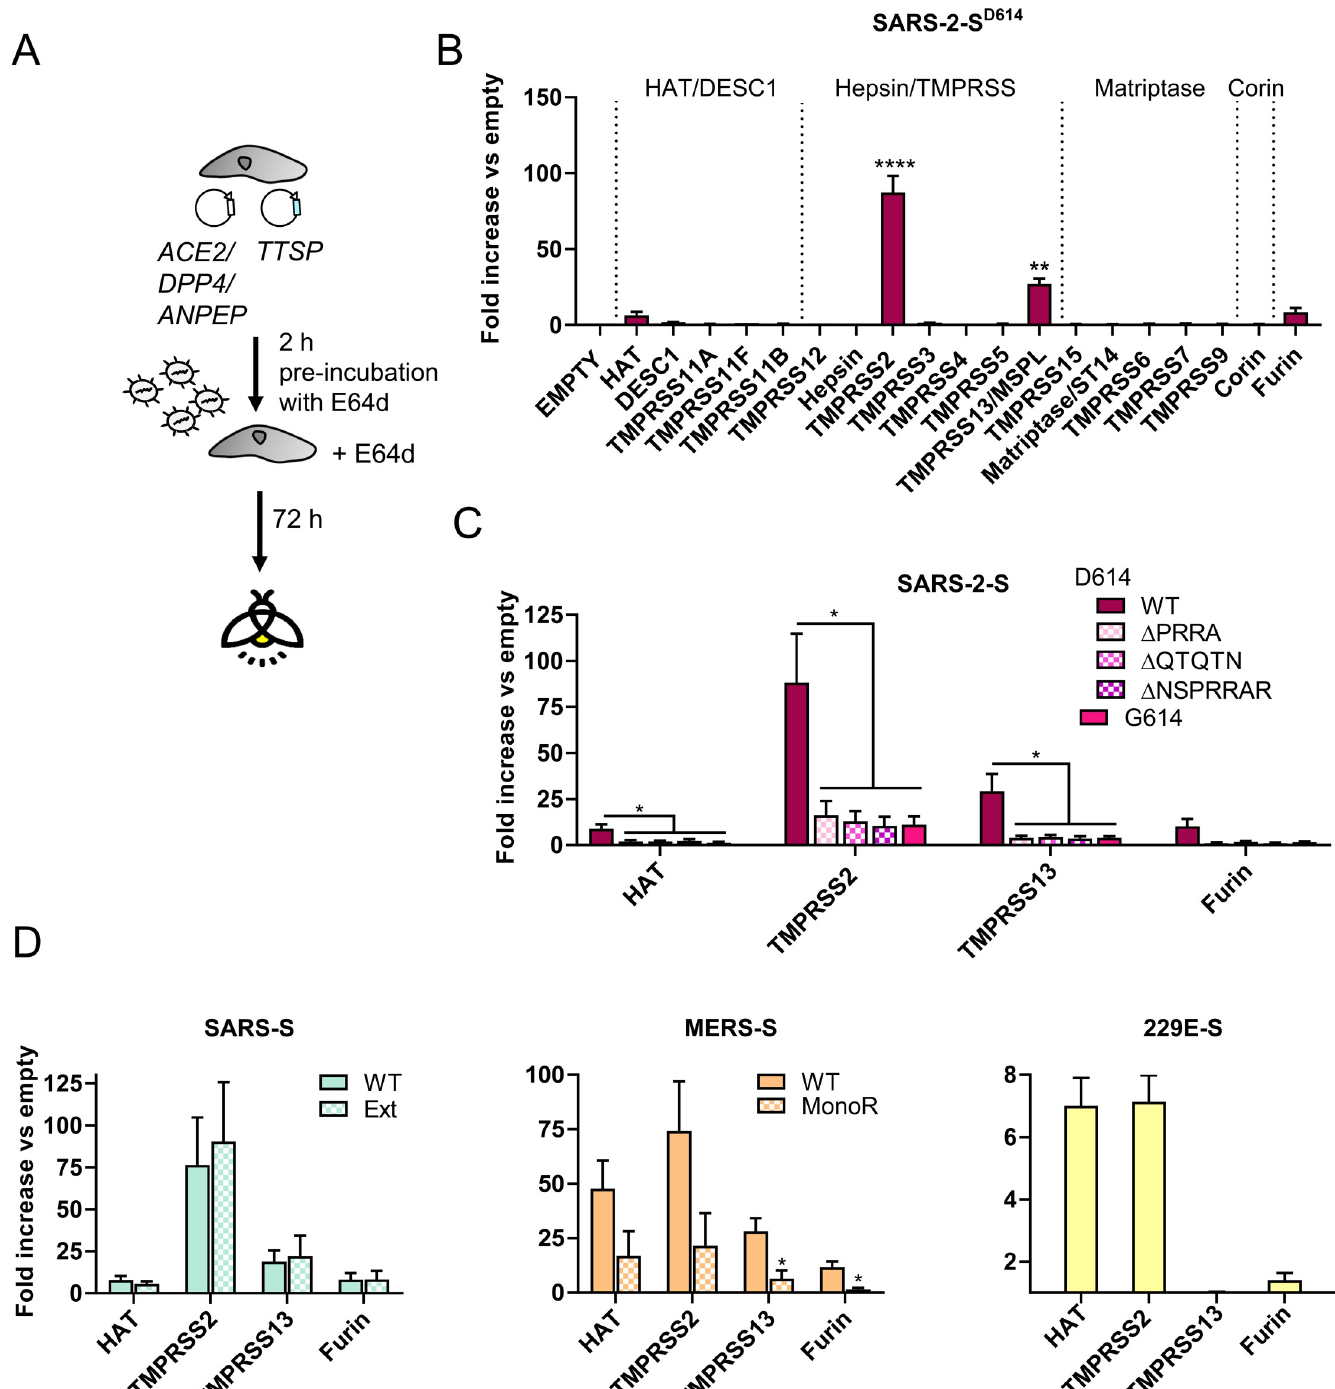
Fig 8. Activation of pseudovirus entry by different human TTSPs. (A) Experiment set-up. One day before transduction, HEK293T target cells were transfected with the appropriate receptor and one of the TTSPs. To block the cathepsin route, E64d was added at 2 h before and during transduction. (B) SARS-2-S activating capacity of the 18 human TTSPs. At the top of the graph, the four TTSP subfamilies are indicated. (C, D) The four TTSPs that proved active in panel B were evaluated for activation of wild-type and mutant forms of SARS-2-S (panel C), or SARS-S, MERS-S and 229E-S (panel D). An ordinary one-way ANOVA with Dunnett’s correction was used to analyze differences for empty versus TTSP plasmid conditions (panel B); and for SARS-2-S mutants versus D614 WT (panel C). Panel D: unpaired two- tailed t-test (WT versus mutant forms). � , P � 0.05; �� , P � 0.01; ���� , P � 0.0001. Results are the mean ± SEM from three experiments.